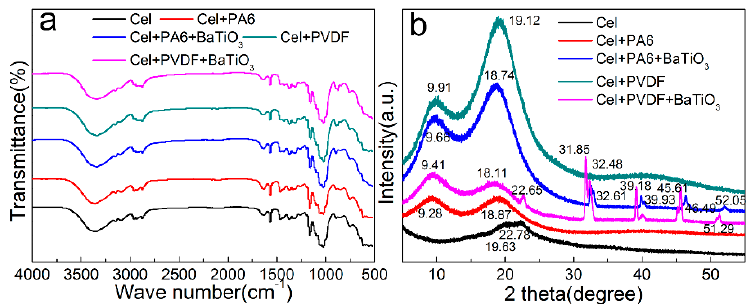
Figure 2. Characterization graphics of different types of friction layers: ( a ) FT-IR diagram, ( b ) XRD diagram.